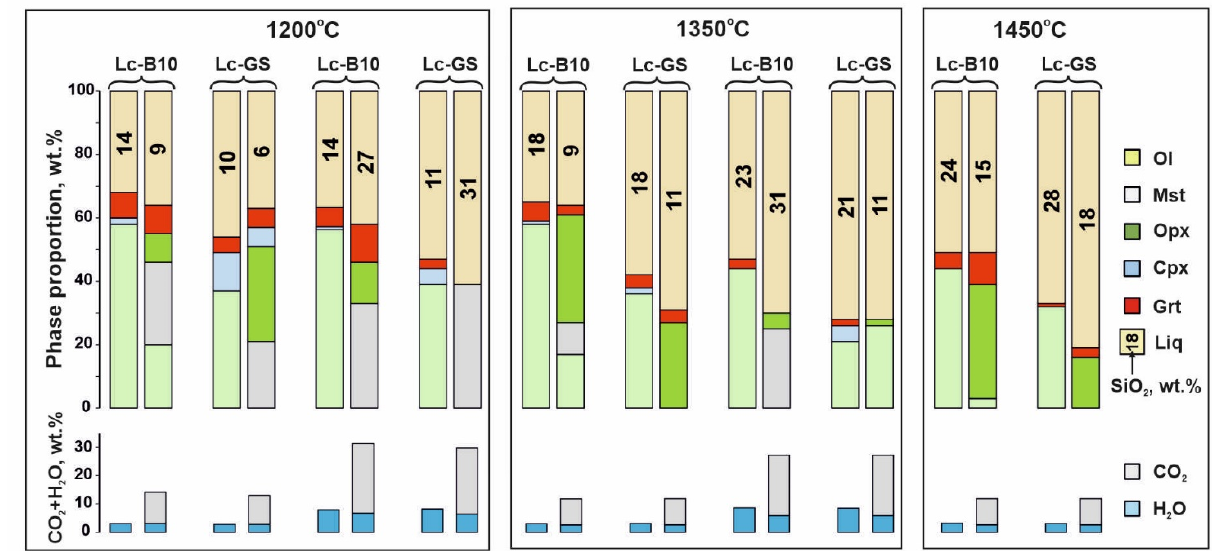
Figure 3. Phase relations in lherzolite-carbonatite B10 (Lc-B10) and lherzolite–GS (Lc-GS) samples as a function of temperature and amounts of added molecular CO 2 and H 2 O. Table 3. Average compositions (wt%) of